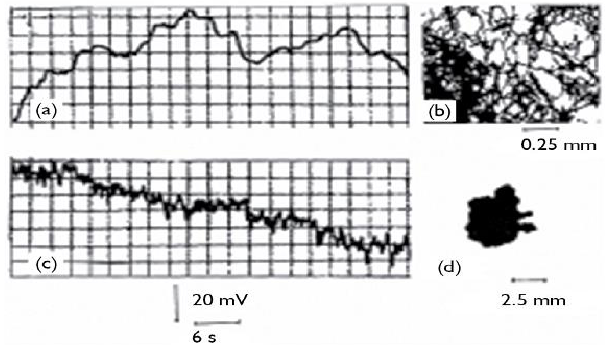
Fig. 1. The oscillatory behavior during the anodic electropolymerization of thiophene with two different background electrolytes-4-TSS (argentum 4-tolylsulphate) (a) and ZnSO (c) and corresponding morphological 4 changes (b,d). Reproduced from [22] with the permission of IN-SCAR,